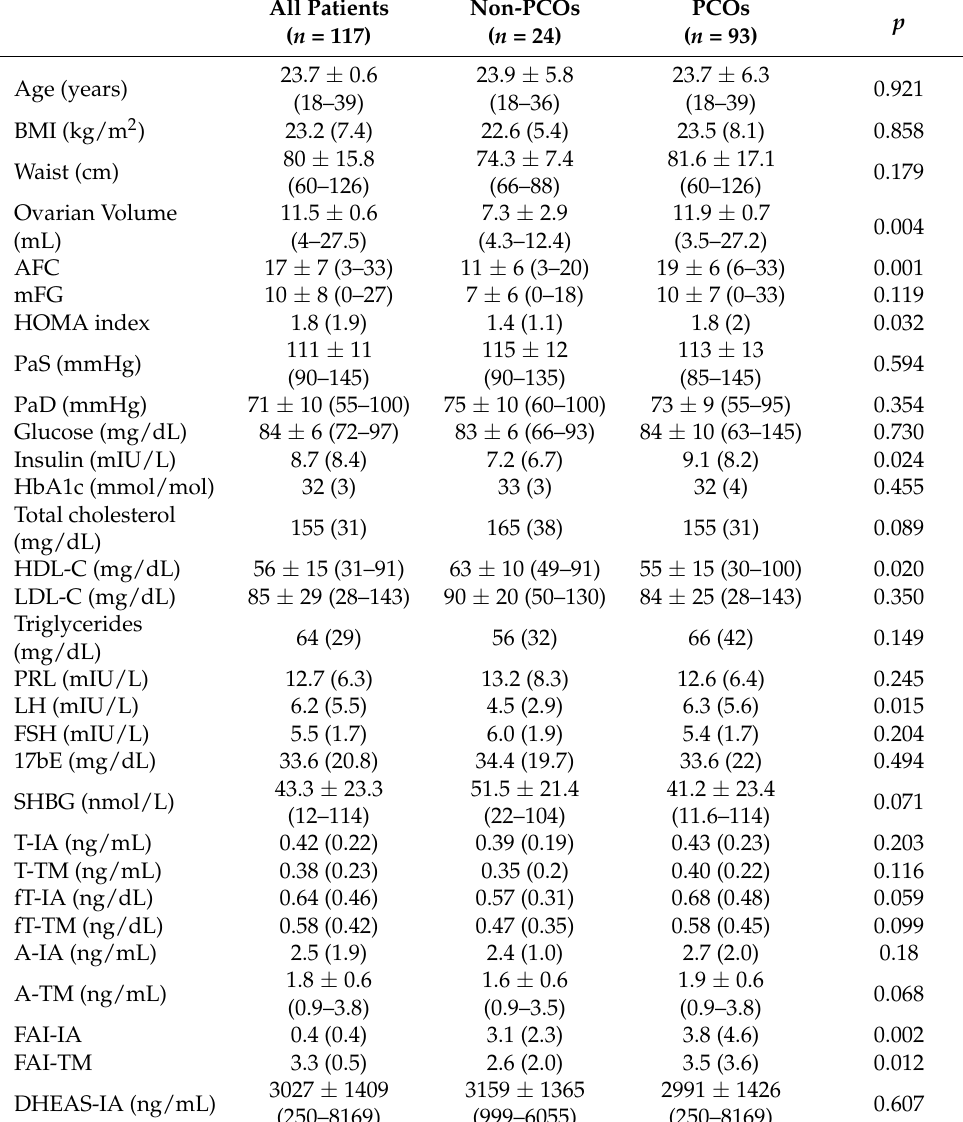
Table 1. Clinical and biochemical characteristics of patients diagnosed as polycystic ovary syndrome (PCOS) or non-PCOS considering testosterone (T), free testosterone (fT), and androstenedione (A) measurement by liquid chromatography in tandem with mass spectrometry (LC-MS/MS). All